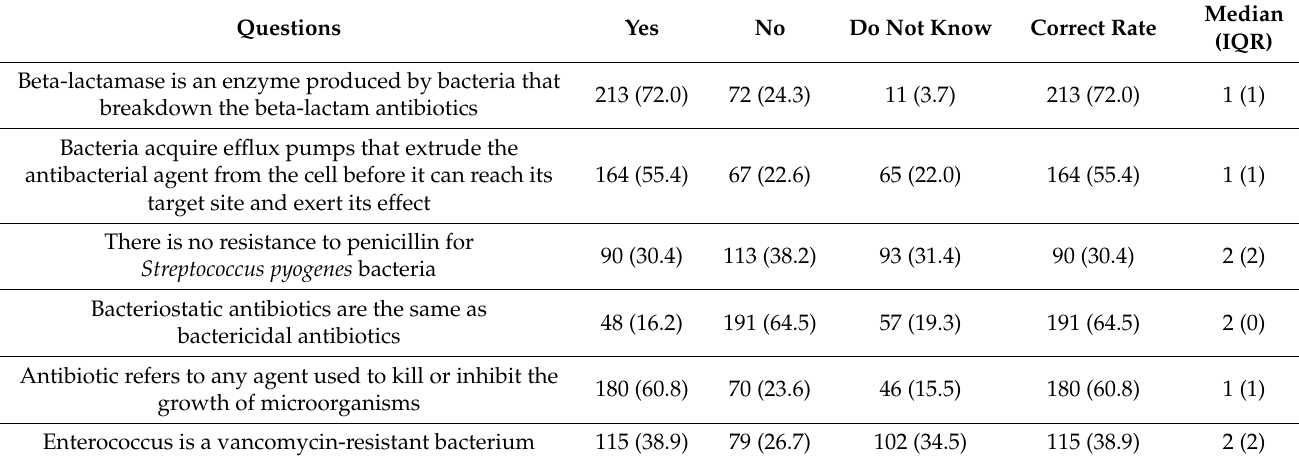
Table 4. Understanding of respondents about the resistance mechanisms of antibiotics n